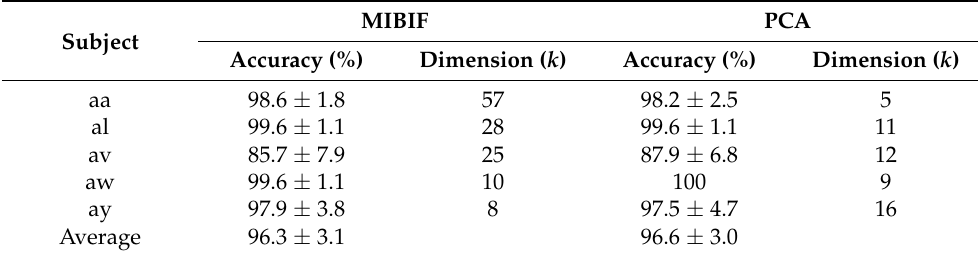
Table 5. The highest classification accuracies and the selected feature dimension ( k ) by MIBIF and PCA for all subjects on Competition III dataset IVa (subject aa, al, av, aw, and ay).